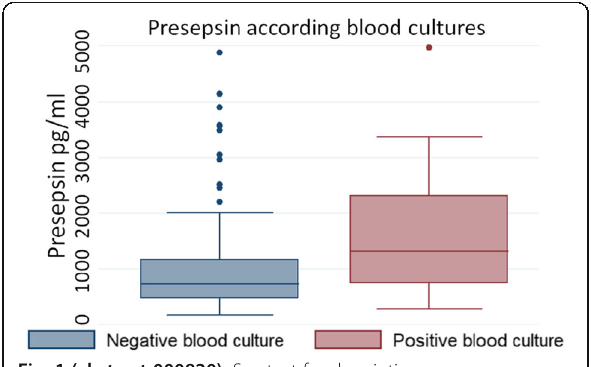
Fig. 1 (abstract 000820). See text for description.